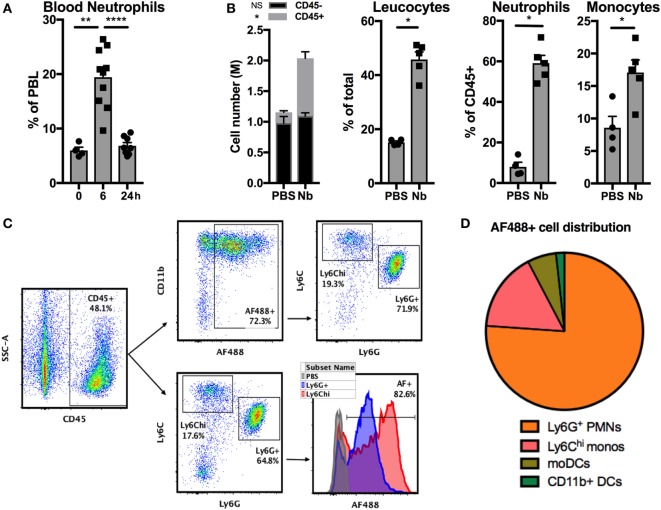
Nippostrongylus brasiliensis (Nb) induces the recruitment and activation of neutrophils in the skin. C57BL/6 mice were injected intradermally into the ear with 600 AF488+ Nb or PBS. The resulting inflammatory response in blood and skin was analyzed by flow cytometry at the indicated time points. Each symbol represents one mouse. (A) Proportion of neutrophils (CD11bhi Ly6G+) in peripheral blood leukocytes (PBL). Data are pooled from two independent experiments. (B) Recruitment of leukocyte populations in the ear skin at 24 h. Leukocytes were identified as CD45+ cells, neutrophils and monocytes were identified according to the gating in panel C. Data are from one of three experiments that gave similar results. (C) Representative dot plots depicting the gating of ear skin CD45+ populations expressing Ly6G (neutrophils), high Ly6C (monocytes), and AF488 as a measure of Nb uptake. (D) Pie chart showing the relative proportion of AF488+ populations in skin, identified as in (C). Monocyte-derived DCs (moDCs) are defined as Ly6G− Ly6Chi CD11bhi CD11c+ MHCII+, and CD11b+ dendritic cells (DCs) are Ly6G− Ly6C− CD11c+ MHCII+ CD11b+ CD326−. Data are from one of three experiments that gave similar results. Bar graphs show mean ± SEM. Statistical analyses used the Mann–Whitney test. NS: not significant; *p < 0.05; **p < 0.01; ****p < 0.0001. (B) Symbols close to the legend indicate a comparison of the same population between the two groups.